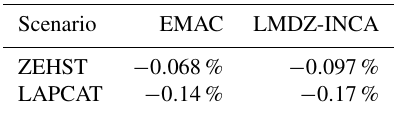
Table 4. Relative total ozone mass change for each model and each aircraft